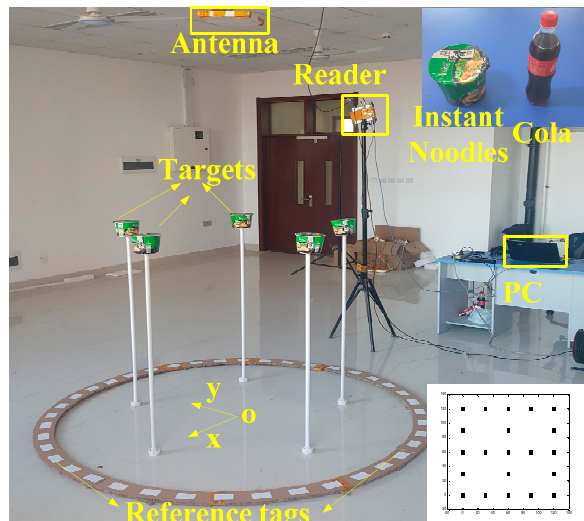
Figure 8. Experimental setup in indoor environment.